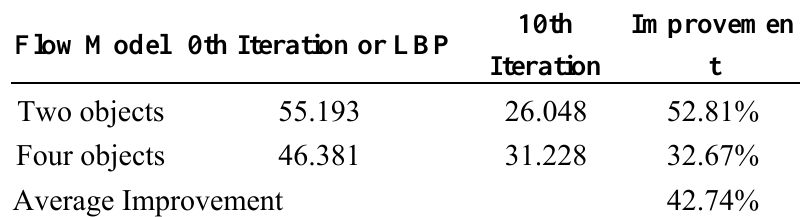
Table 2. Improvement of reconstructed image using SIE error